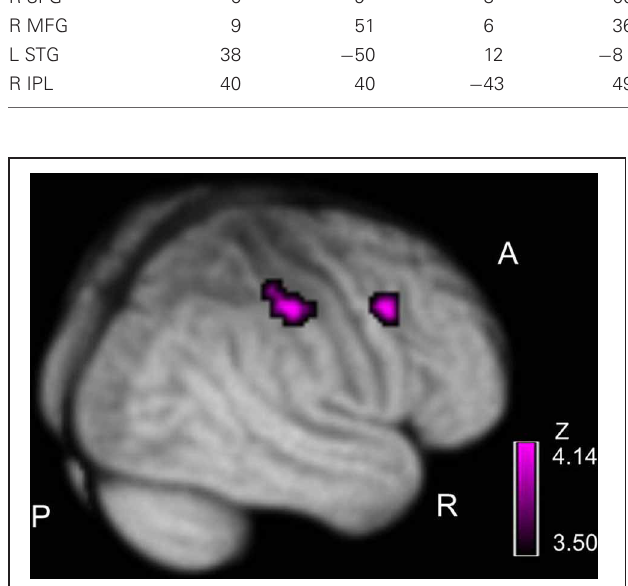
FIGURE 7 | Positive correlation between severity of hallucinatory behavior and cerebral activation under FJT > GDT contrast. Purple color bar shows z -value. Statistical threshold: p < 0 . 25, FDR-corrected; R, right; A, anterior; P,